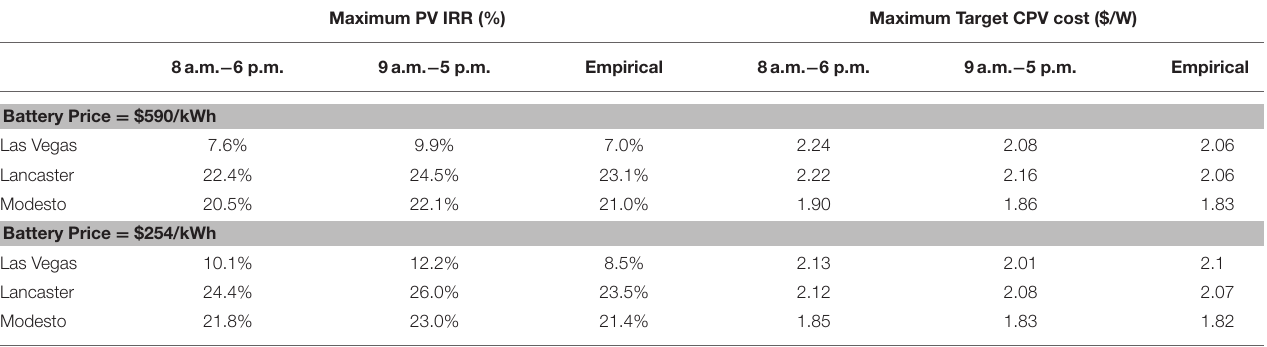
TABLE 4 | Optimal PV IRR under 3 load profiles in 3 cities and the target CPV cost required to match that